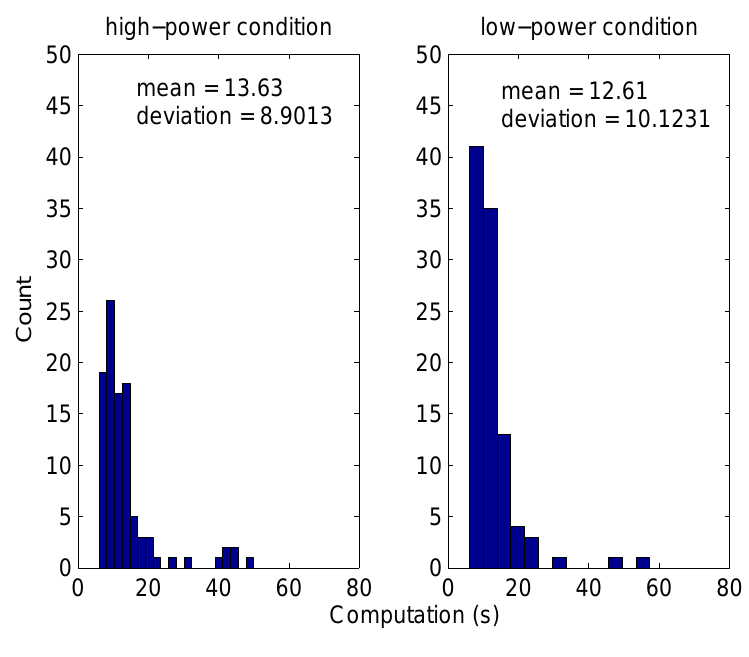
Figure 23. Histogram of the computation time under the quality of service-oriented policy for ( left ) high and ( right ) low power storage levels.